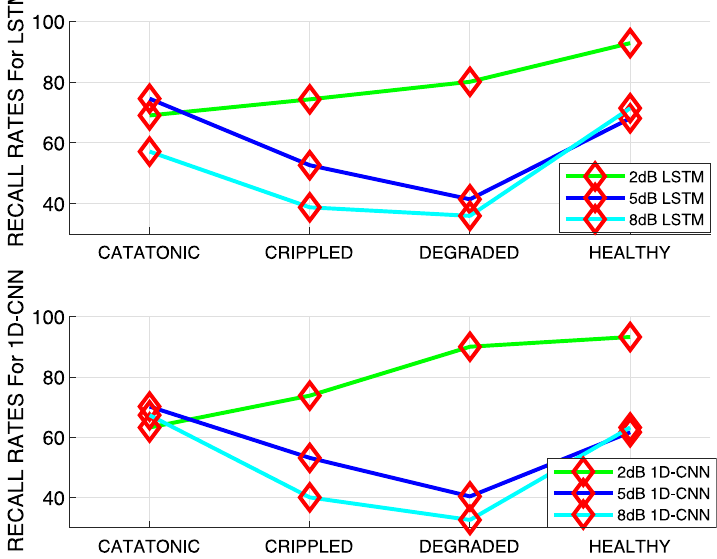
Fig. 9 Recall rates of LSTM and 1D CNN at 30 meters of ROI under ensemble